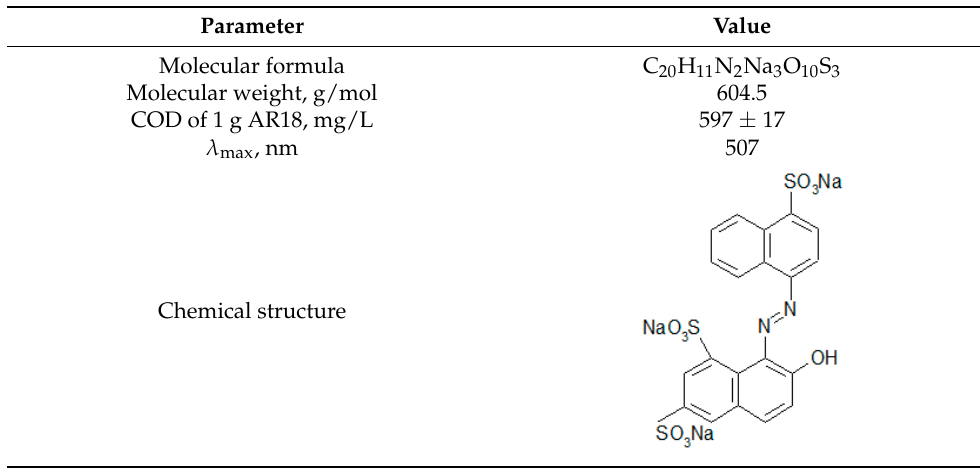
Table 1. General characteristics of C.I. AR18.